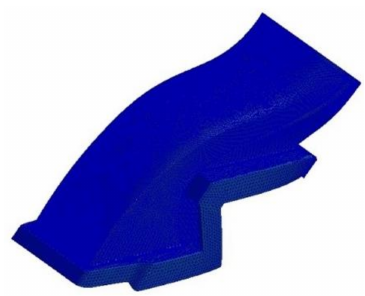
Figure 7. Finite element model of